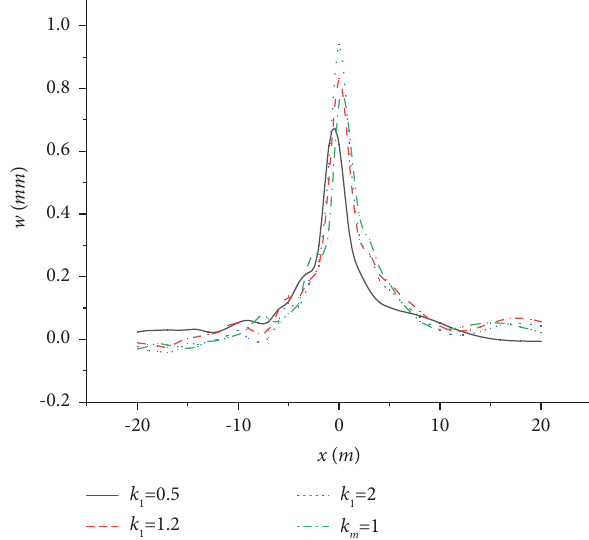
Figure 4: Plate deformation curves in x- direction due to E